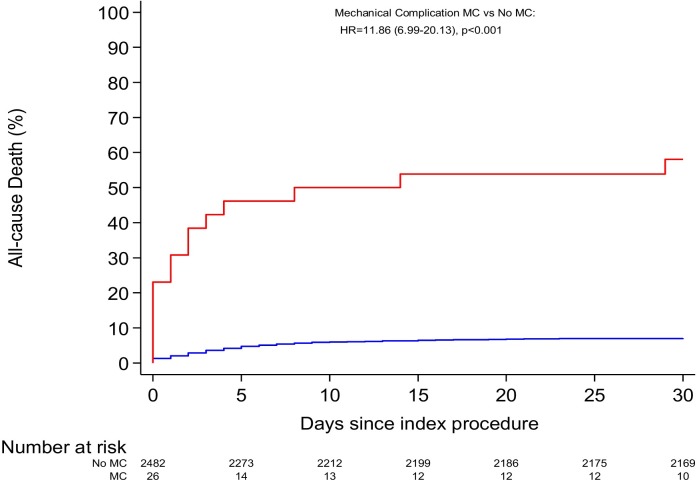
Survival curves.Depicted are survival curves for all-cause mortality based on the product-limit estimator comparing patients with and patients without a mechanical complication in the context of an ST-elevation myocardial infarction.